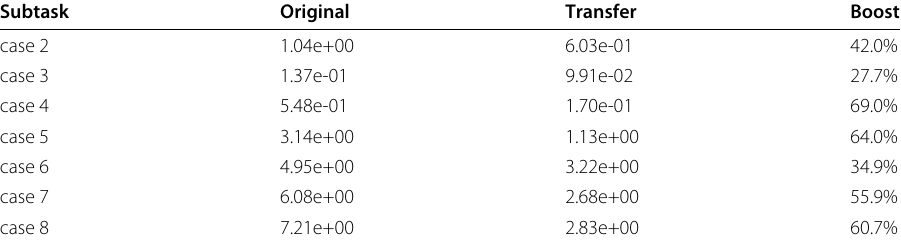
Table 7 Performance boost of PINN on the Helmholtz benchmarks using transfer learning Subtask